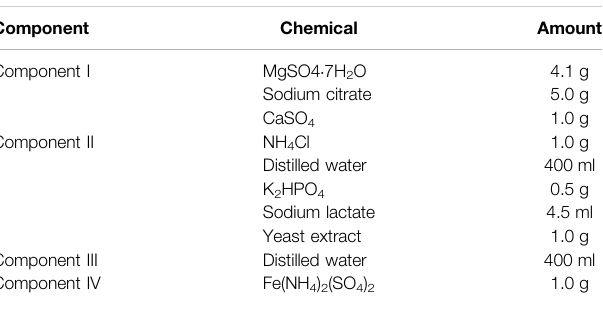
TABLE 2 | Chemical composition of ATCC 1249